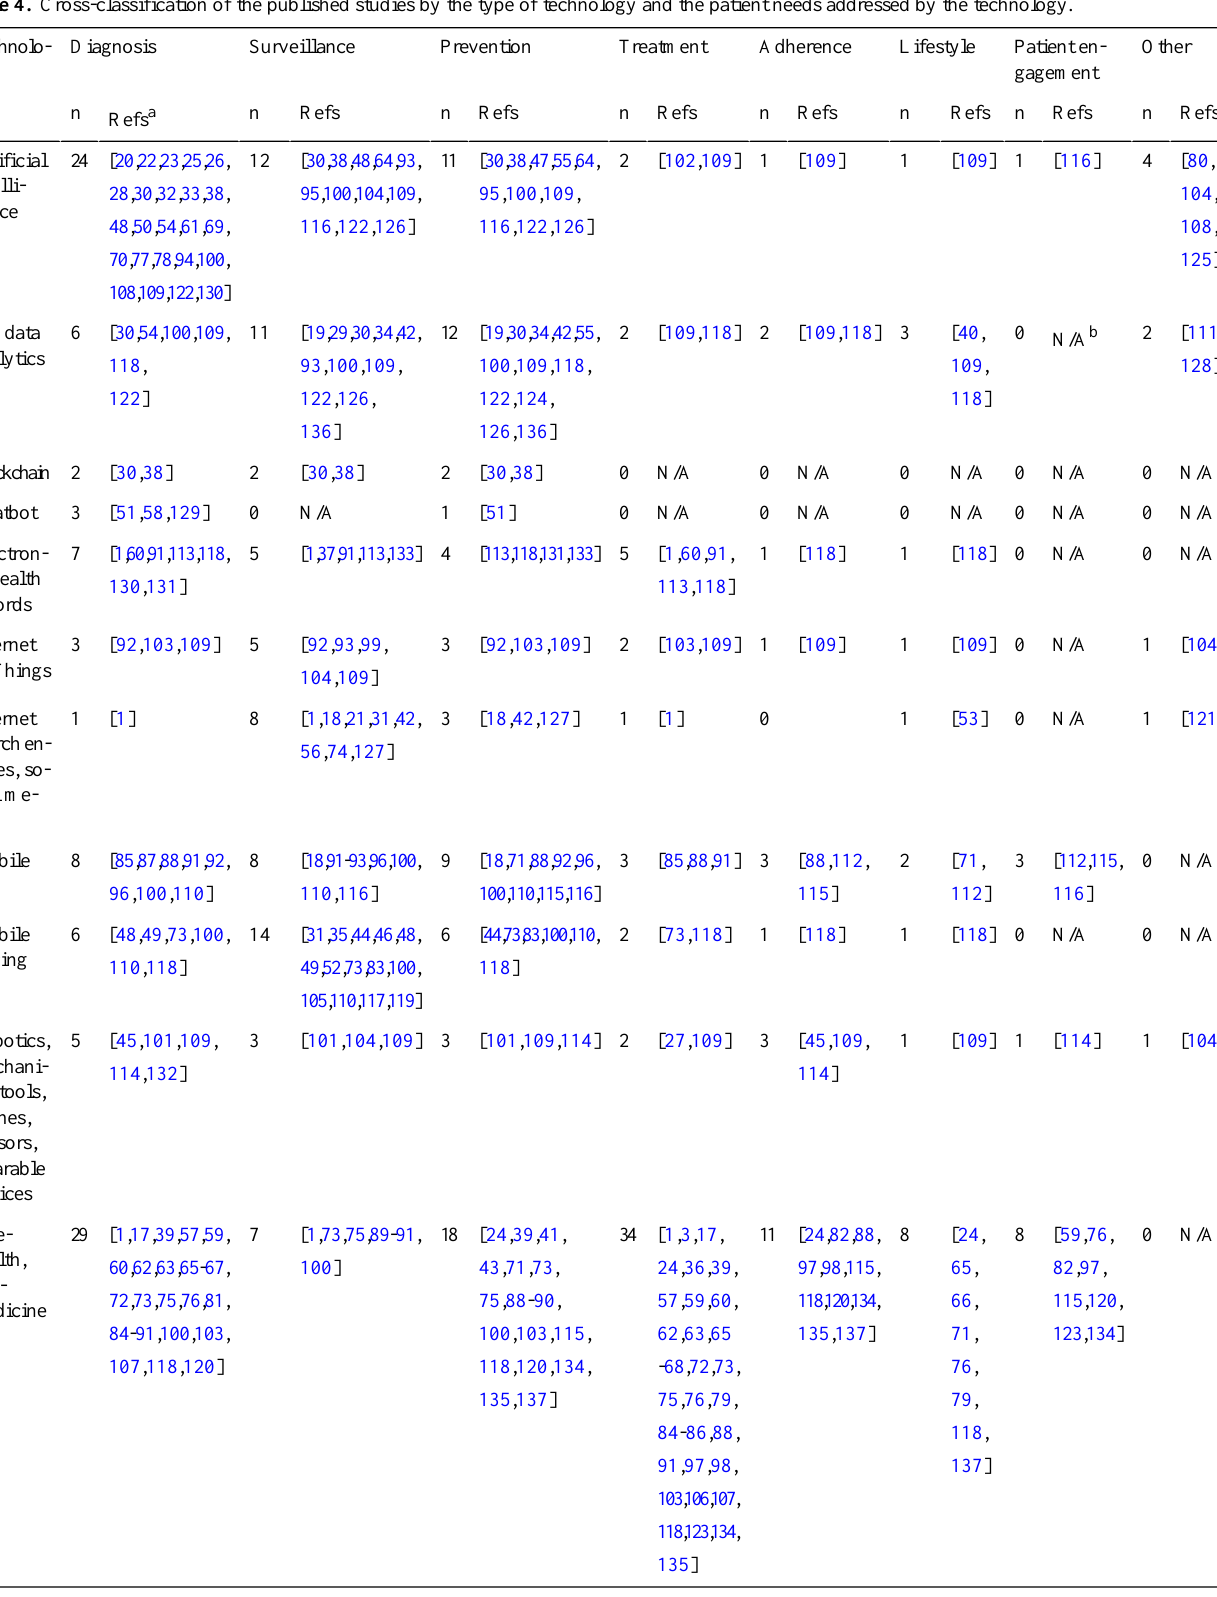
Table 4. Cross-classification of the published studies by the type of technology and the patient needs addressed by the